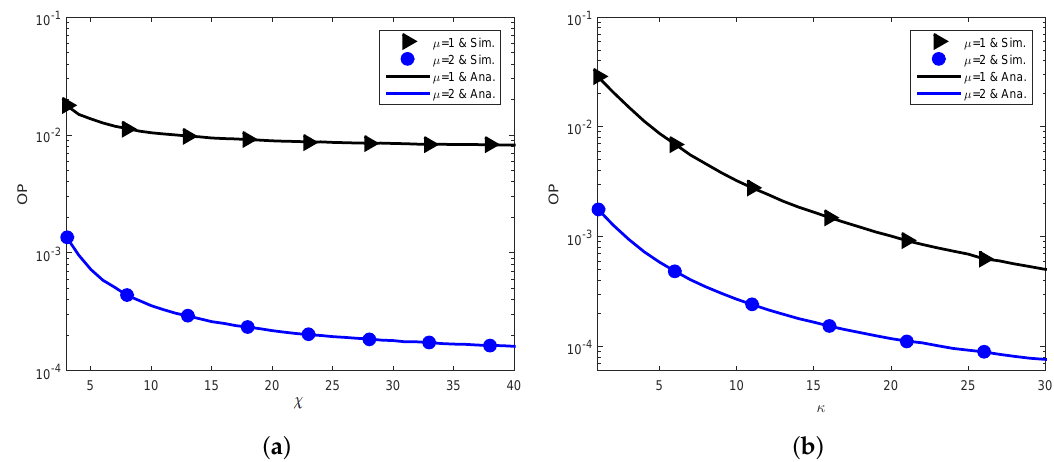
Figure 6. Shadowed fading parameters ( µ , χ , κ ) . ( a ) OP versus χ . ( b ) OP versus κ